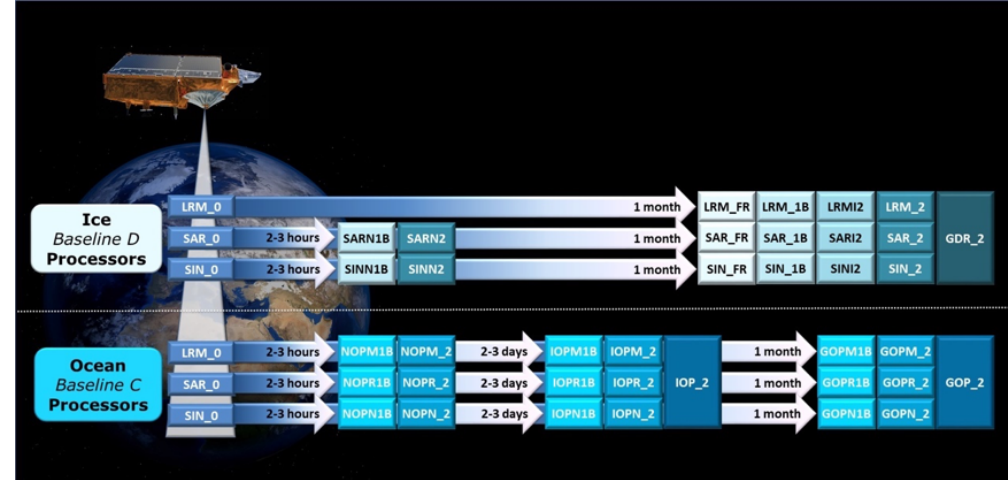
Figure 1. CryoSat data products overview. Map data ©2019